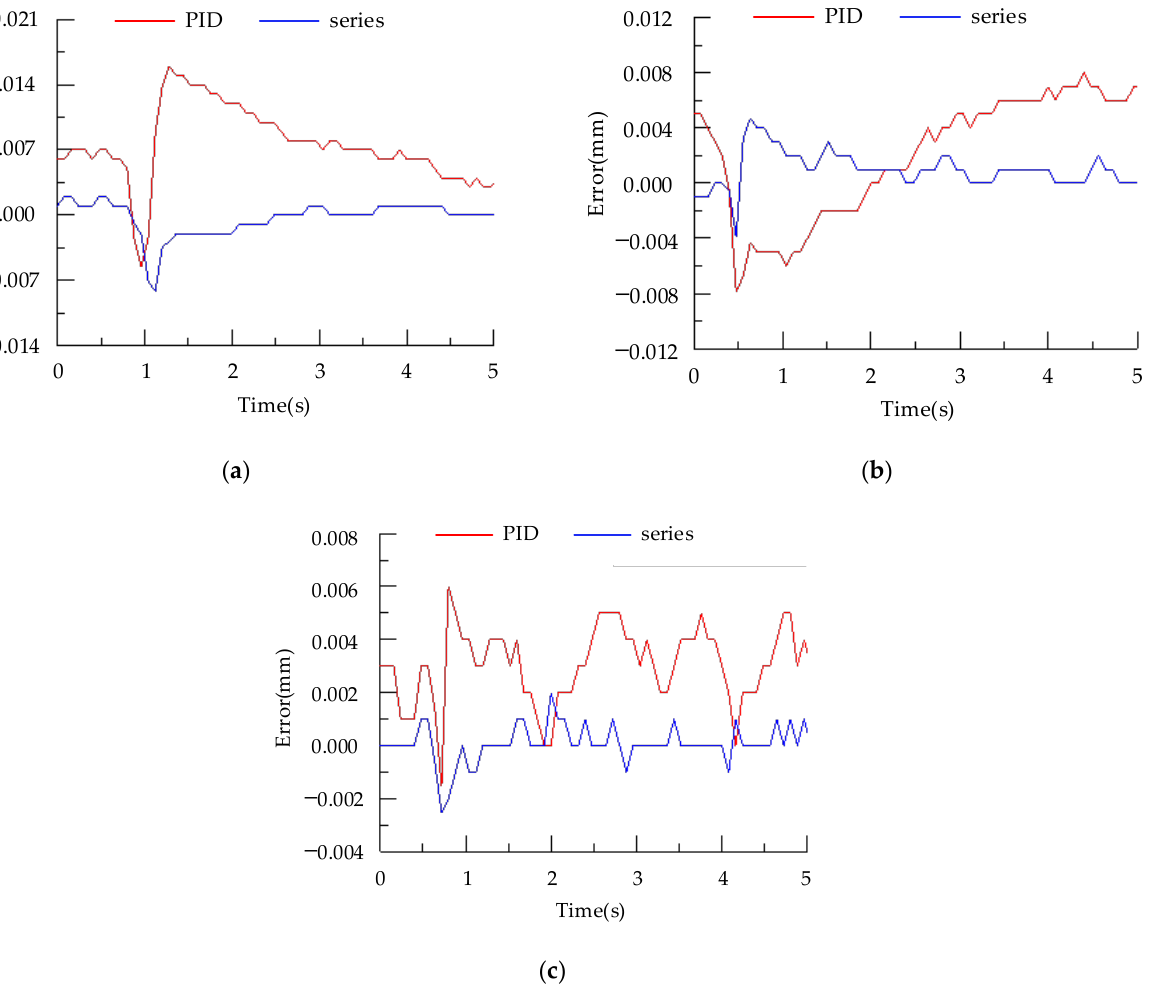
Figure 12. Error curve. ( a ) Error with displacement of 0.1 mm; ( b ) error with displacement of 0.05 mm; ( c ) error with displacement of 0.01 mm.